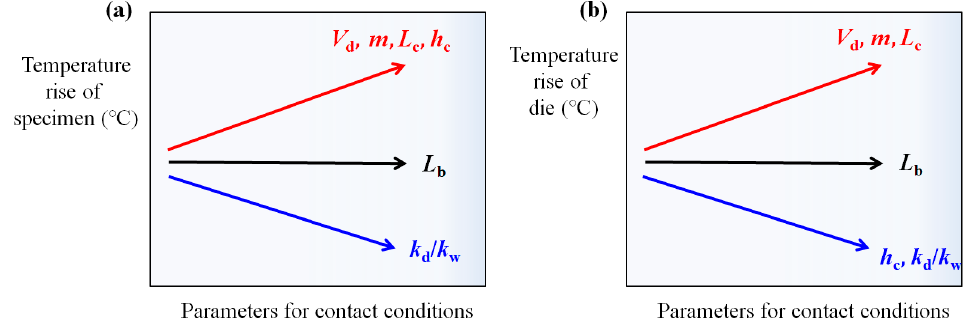
Figure 11. Schematic illustration showing effects of contact conditions on temperature increase in ( a ) specimen and ( b ) die during wire drawing.